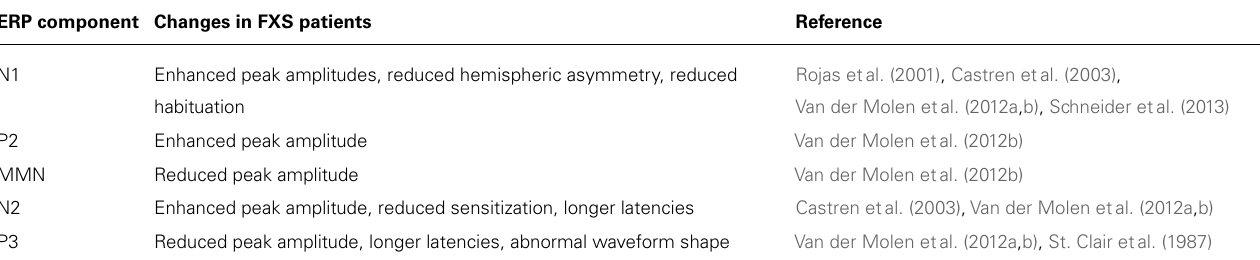
Table 1 | Summary of auditory processing abnormalities in humans with FXS determined using auditory ERP. ERP component Changes in FXS